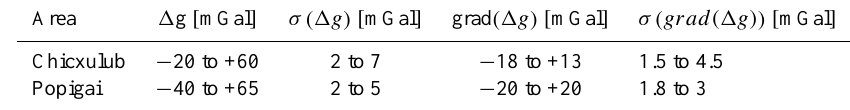
Table 1. Range of 1g , grad ( 1g ) and its estimated errors for the Chicxulub and Popigai areas. Area 1 g [ mGal ]